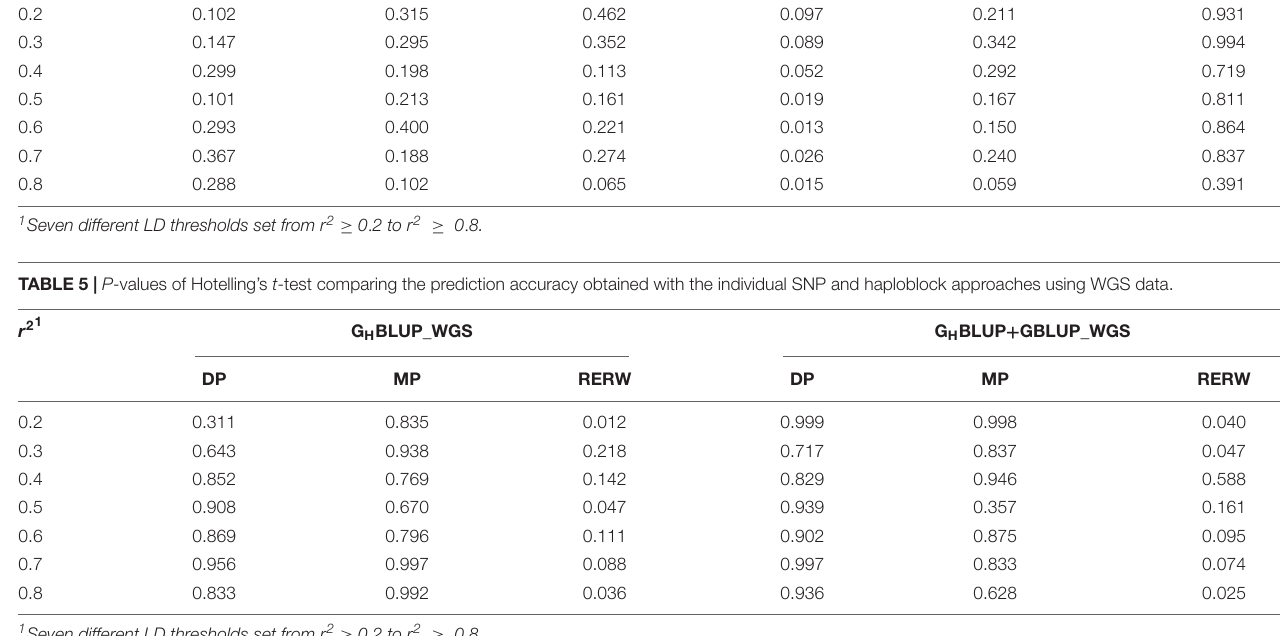
Frontiers in Genetics |